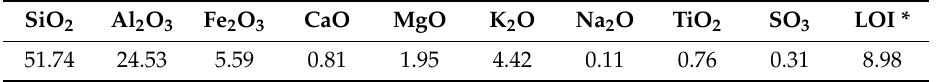
Table 1. Main chemical compositions of fly ash (wt.%).